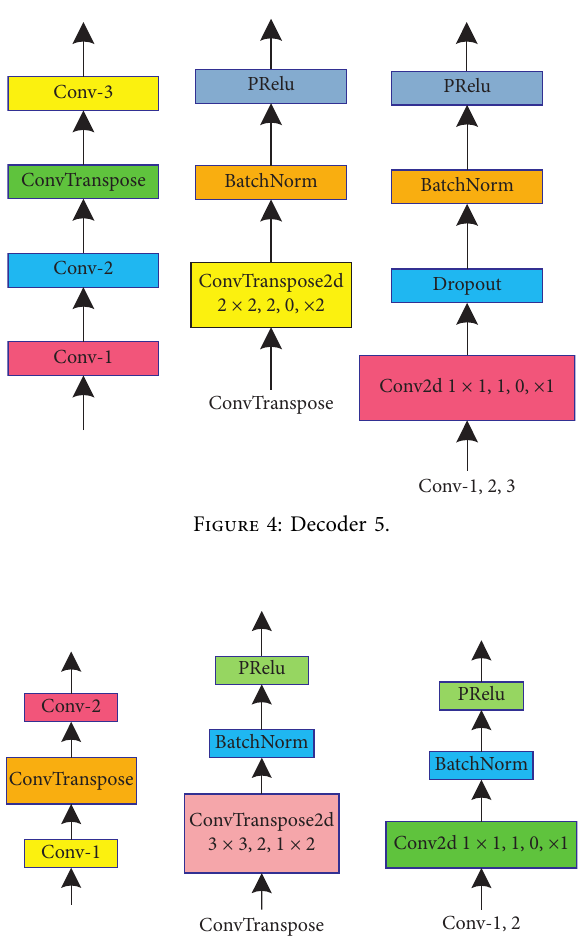
Figure 5: Decoders 4, 3, 2, and